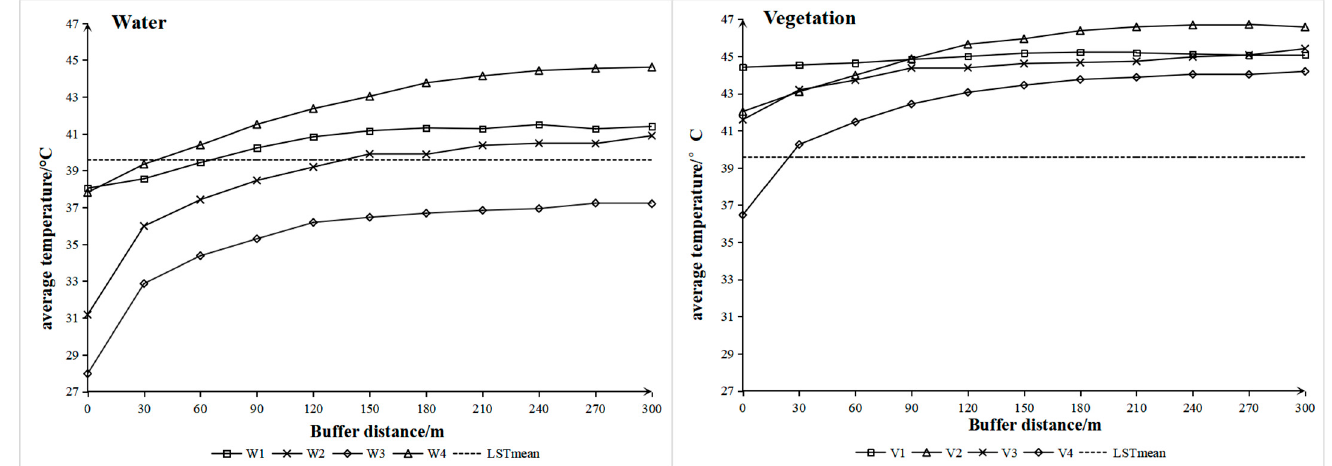
Figure 7. Trends of LST in different distances from water ( left ) or vegetation ( right ). The tempera- ture of each ring buffer does not include the temperature of the patch itself. The dotted line repre- sents the average LST. average